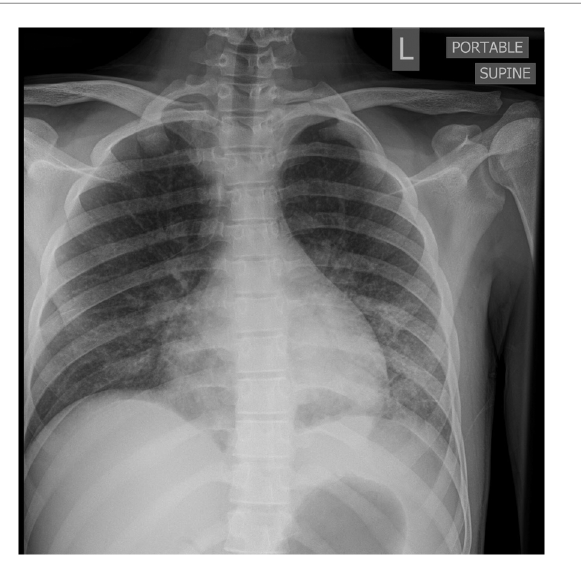
FIGURE 4 AP portable chest radiograph with diffuse but lower lobe predominant micronodular opacities and air